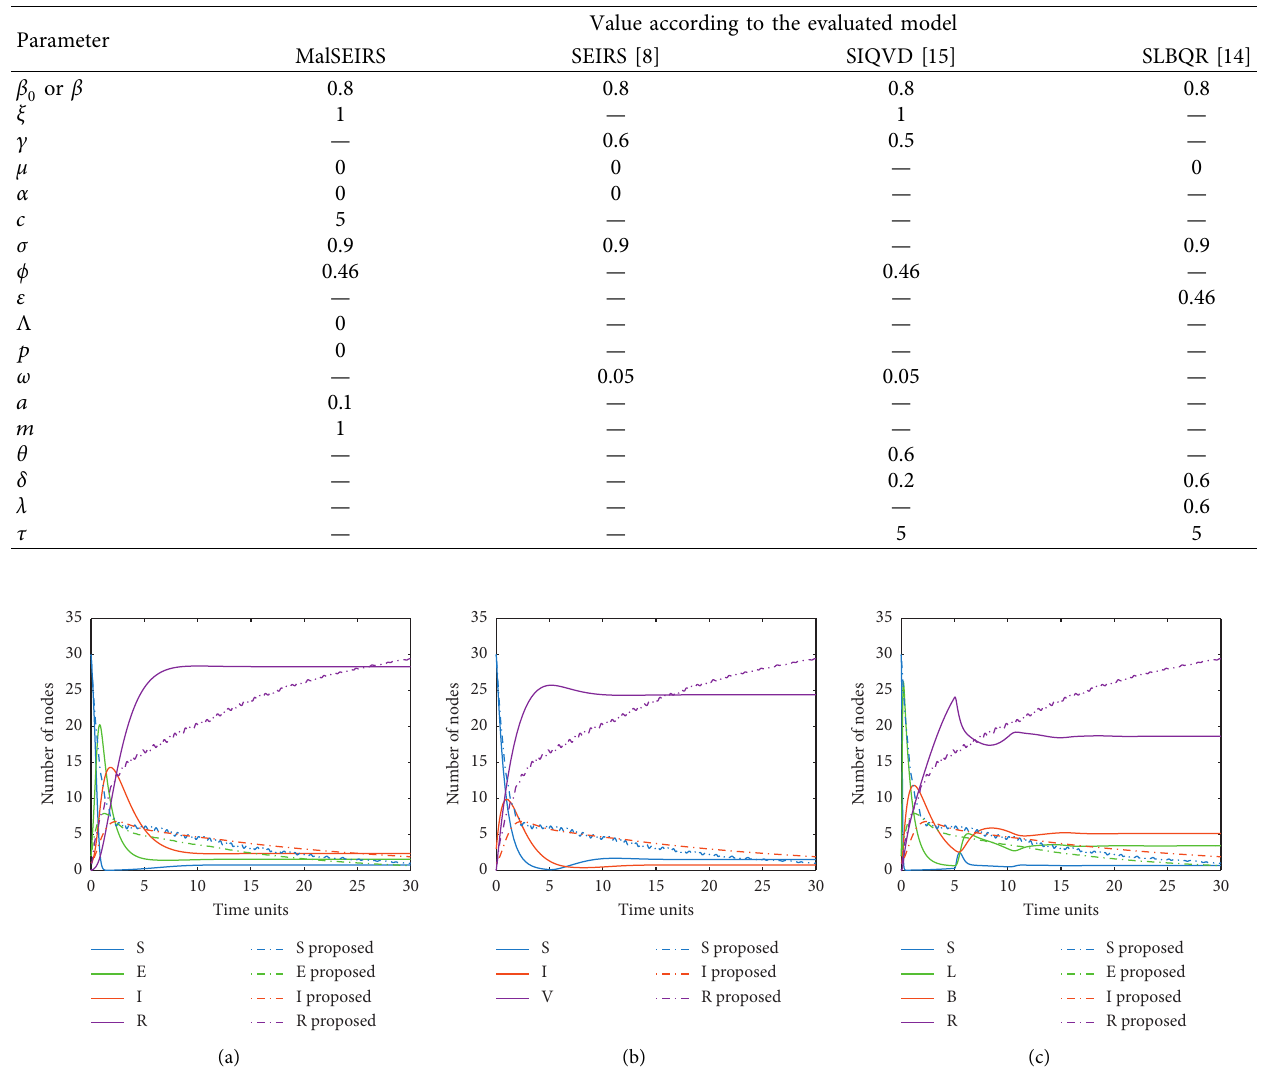
Value according to the evaluated model